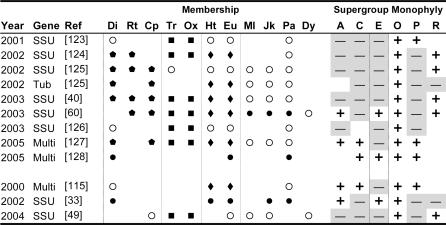
Support for Membership and Supergroup Monophyly from “Excavata”-Targeted Molecular GenealogiesMember taxa: Di, Diplomonadida; Rt, Retortamonadida; Cp, Carpediemonas; Tr, Trimastix; Ox, Oxymonadida; Ht, Heterolobosea; Eu, Euglenozoa; Ml, Malawimonas; Jk, Jakobida; Pa, Parabasalia; Dy, Diphylleia. Hypothesized subgroups:  Fornicata clade (Di + Rt + Cp) monophyletic, Preaxostyla clade (Ox + Tr) monophyletic, ♦ Discicristata clade (Ht + Eu) monophyletic. The position of Diphylleia, Dy, was not considered when scoring the monophyly of “Excavata” as the inclusion of this organism within “Excavata” is controversial and has been removed from recent classifications (see text). See Figure 4 for further notes. References cited in this figure are [33,40,49,60,115,123–128].